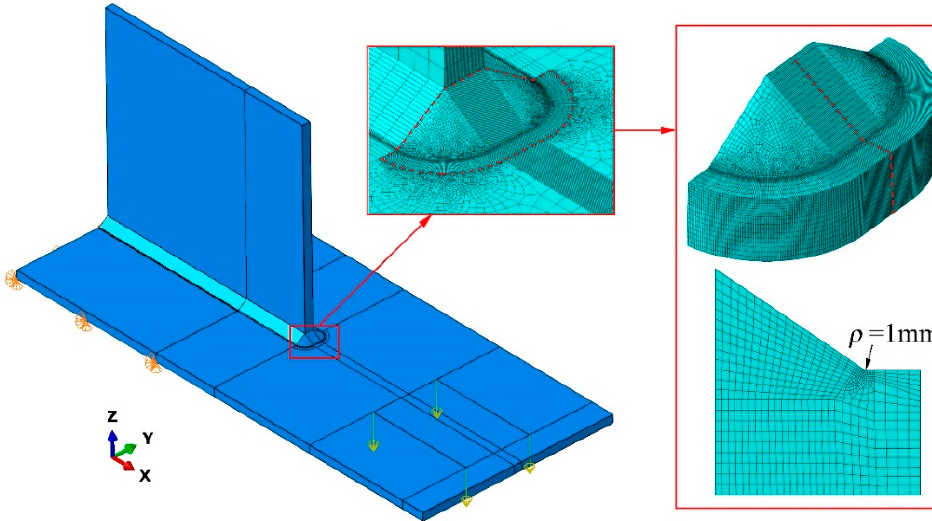
Figure 13. Finite element model for effective notch stress analysis.